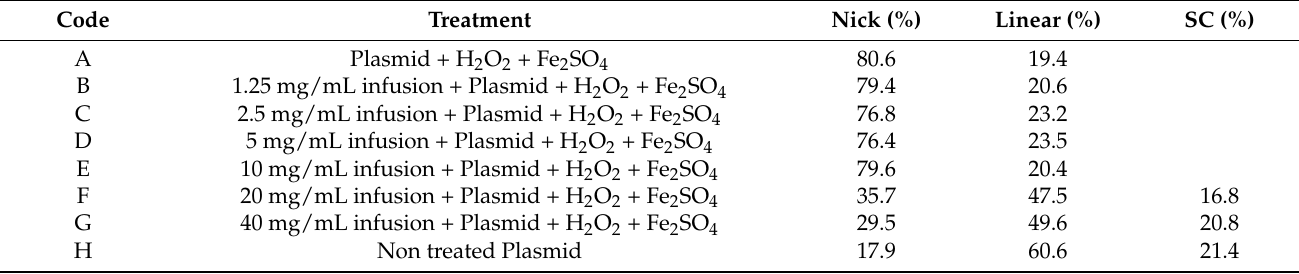
Table 2. Antimutagenic